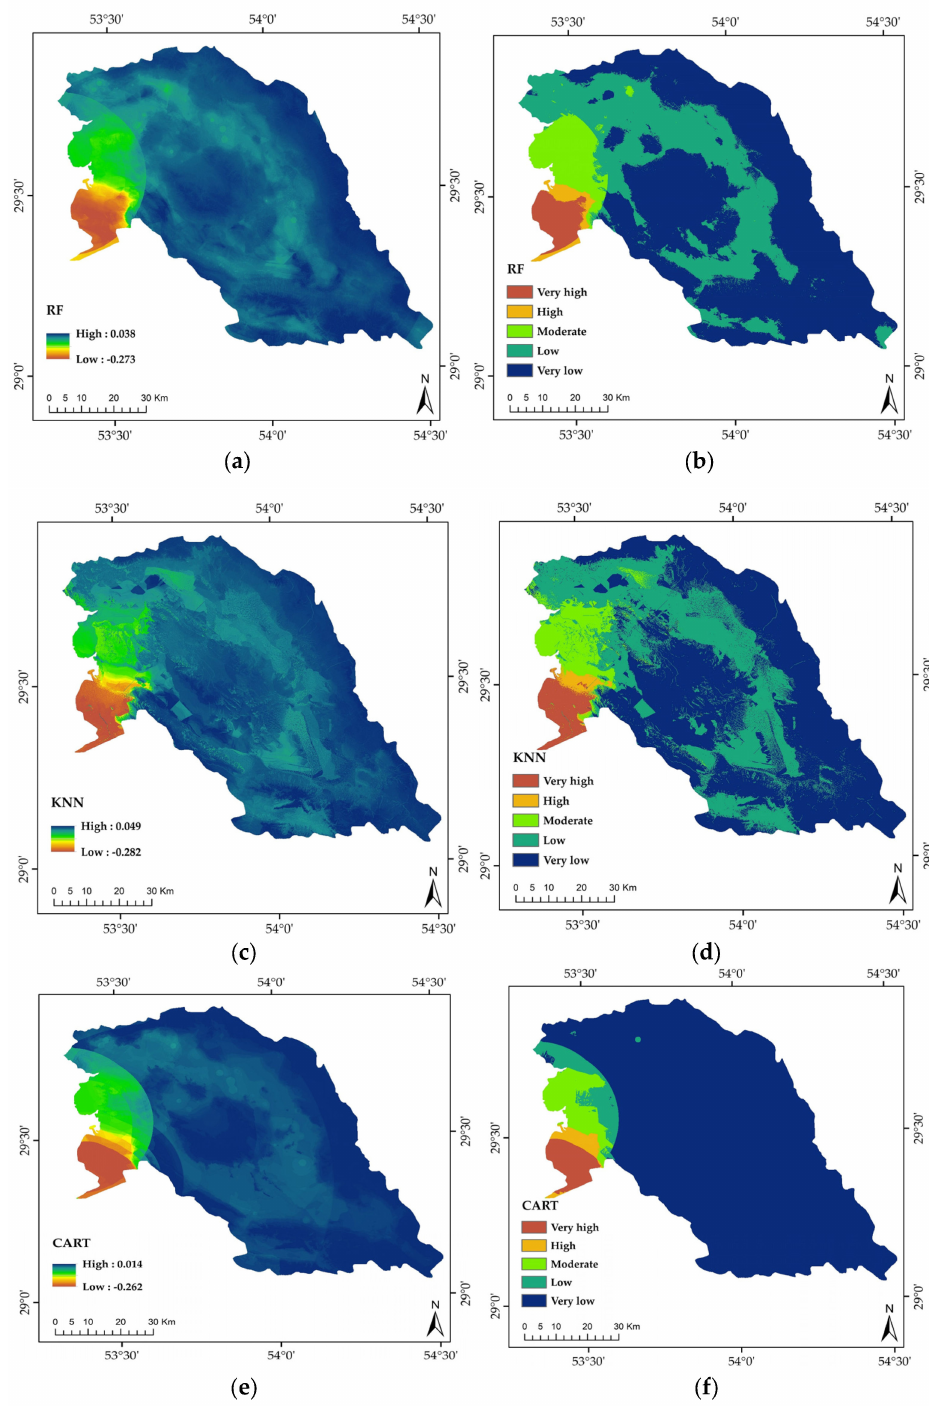
Figure 6. Land subsidence (LS) susceptibility prediction maps via different machine learning models: random forests (RF; ( a , b )), k-nearest neighbors (KNN; ( c , d )), and classification and regression trees (CART; ( e , f